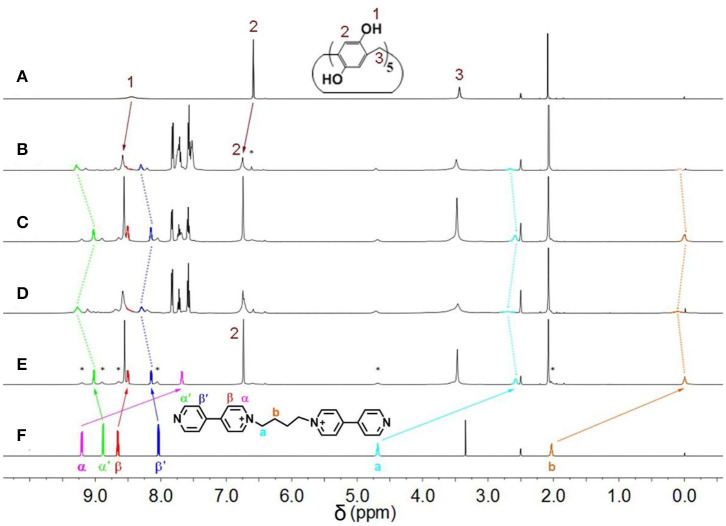
1H NMR spectra (DMSO-d6, 298 K, 500 MHz) of polypseudorotaxane and building units. (A) P5A; (B) P5A + 1
+ [PdCl2(PhCN)2] + PPh3 + [PdCl2(PhCN)2]; (C) P5A + 1
+ [PdCl2(PhCN)2] + PPh3; (D) P5A + 1
+ [PdCl2(PhCN)2]; (E) P5A + 1, (F) 1. ([P5A] = [1] = [PdCl2(PhCN)2] = 60.0 mM; *represent uncomplexed P5A and free 1).